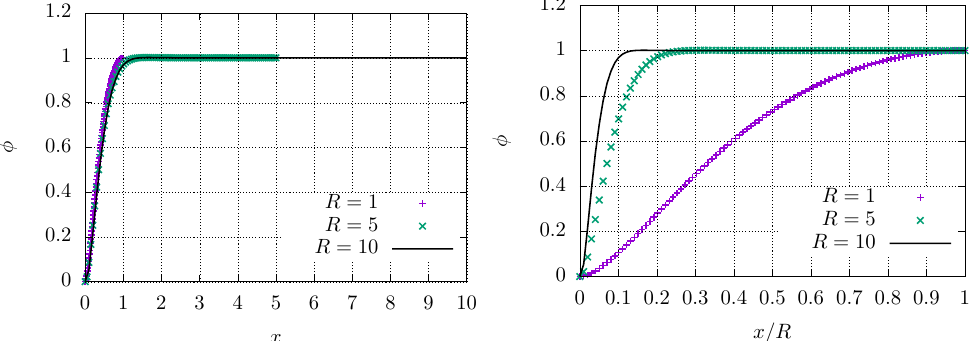
Figure 2. Phase field distribution for R = 1,5,10 in dimensional ( left plot ) and dimensionless ( right plot )